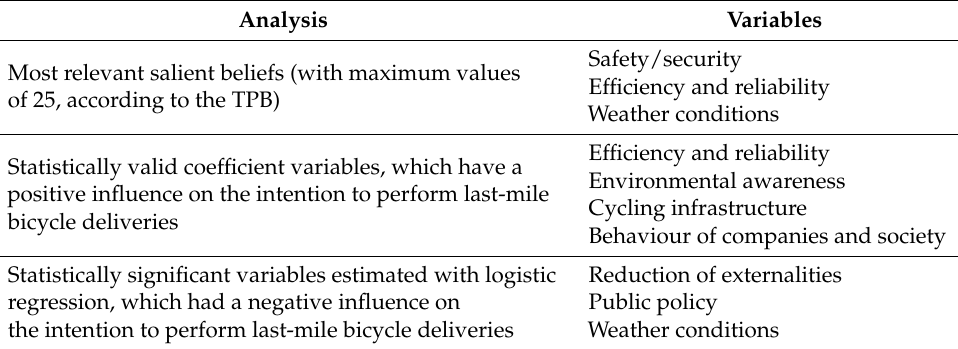
Table 4. Summary of the variables that influence using a